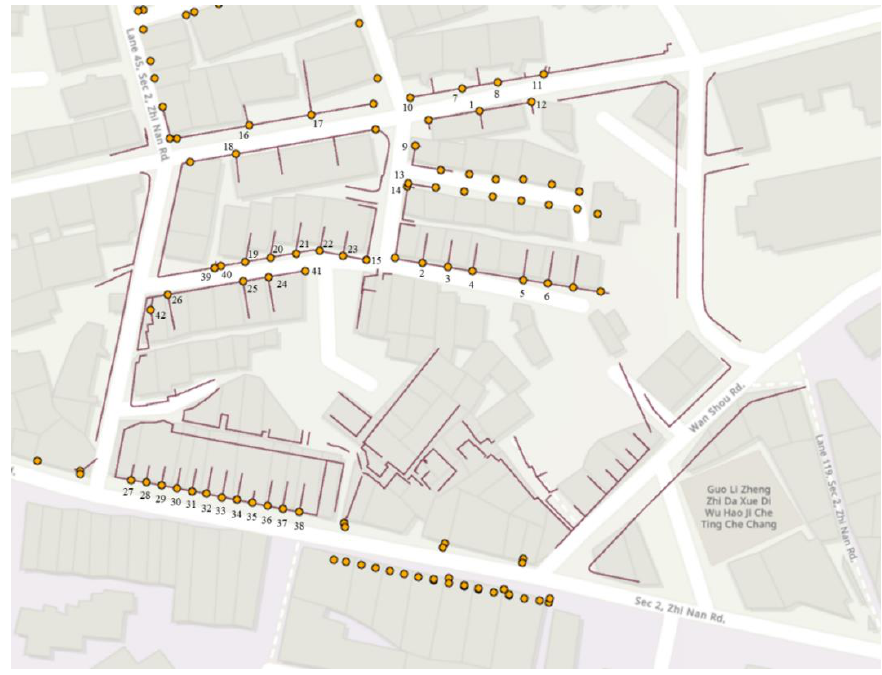
Figure 27. The digitized results of the corrected handheld LiDAR points and detail points surveyed by a total station.